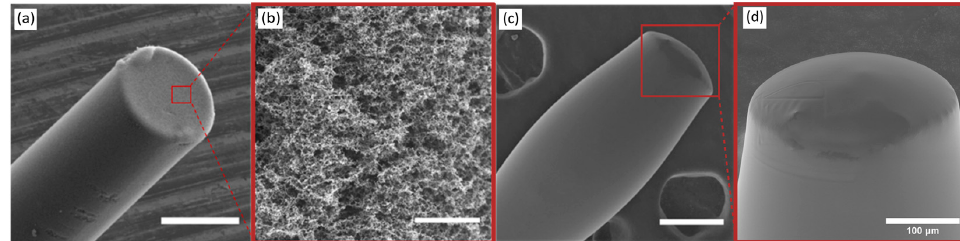
Figure 2. Scanning electron microscopy (SEM) images of the coating on the end face of the optical fibre where ( a ) is the CSNP coating, ( b ) is a magnified view of the CSNP nanostructure, ( c ) is the CSNP-PDMS bilayer nanocomposite coating, and ( d ) is a magnified view of the CSNP-PDMS coating. Scale bars are 200 μ m for ( a , c ), 5 μ m for ( b ), and 100 μ m for ( d ).